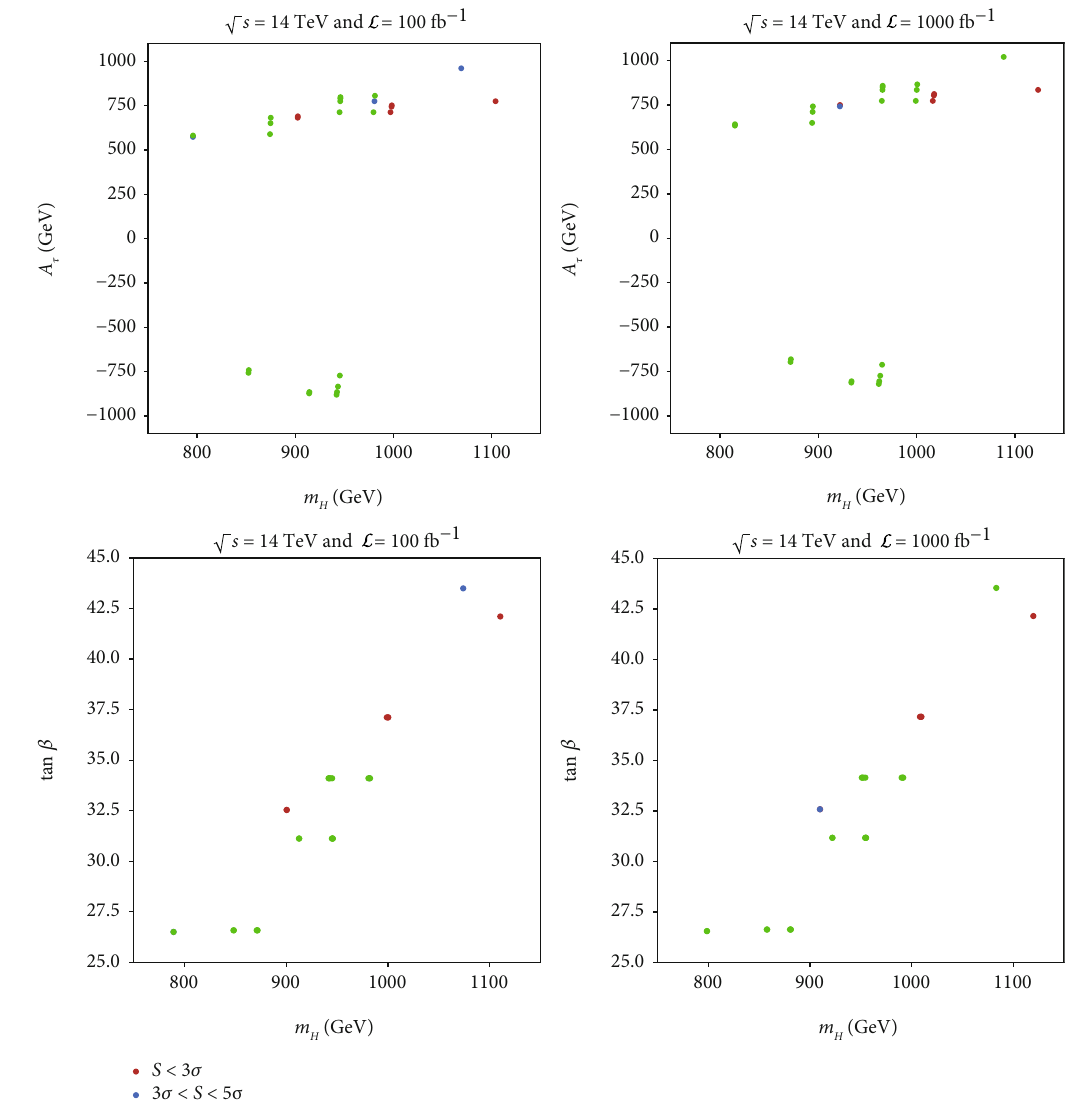
Figure 3: Signal signi fi cance in the ½ m , A τ (cid:2) plane (a, b) and ½ tan β , A τ (cid:2) plane (c, d), within Scenario I for a center-of-mass energy of ffiffi p H = 14 TeV and total integrated luminosities of 100 fb -1 (a, c) and 1000fb -1 (b, d). Red circles correspond to signi fi cances below the s evidence level ( S < 3 σ ), blue circles to signi fi cances between the evidence level and the discovery one ( 3 σ < S < 5 σ ), and green circles to signi fi cances larger than the discovery level ( S > 5 σ